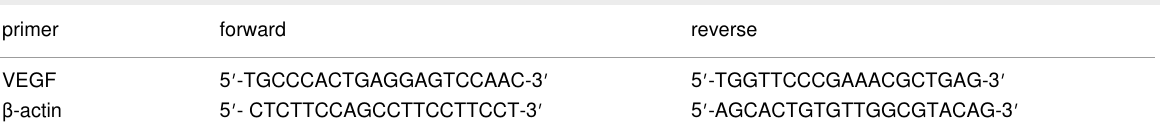
Table 1: Primers used for gene expression studies.